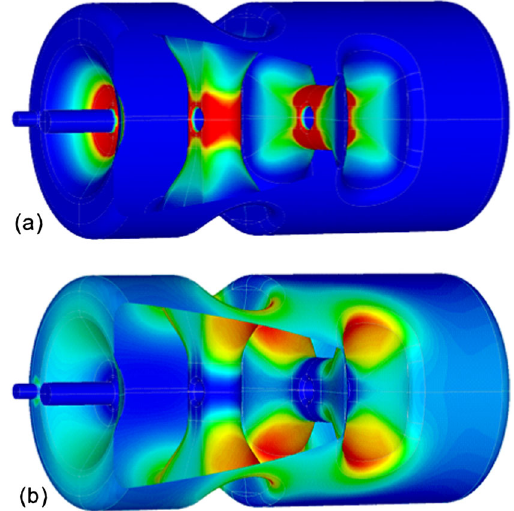
FIG. 36. CST MWS (cid:1) cut-away view showing the surface (a) electric and (b) magnetic fields of the fundamental mode of the optimized 325 MHz, (cid:1) 0 ¼ 0 : 82